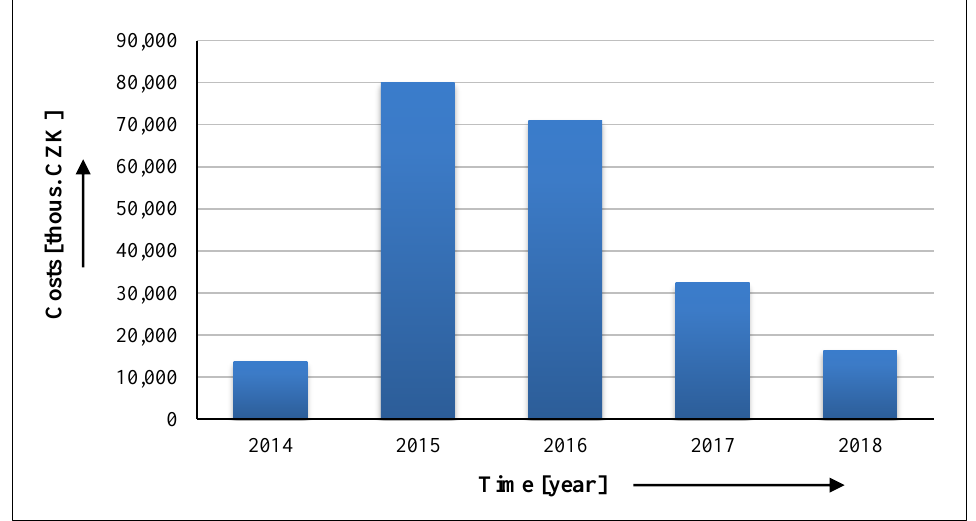
Figure 2. Release of funds from the reserves of Chapter 398 - VPS regarding Vrbětice emergency in 2014–2018 Expenditures on FRSCR and PCR